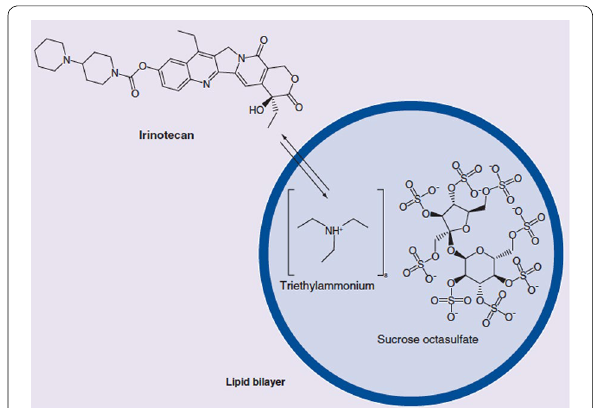
Fig. 6 Depiction of the exchange of triethylamine for irinotecan, which forms a stable complex with sucrose octasulfate inside the liposome (Reproduced with permission from